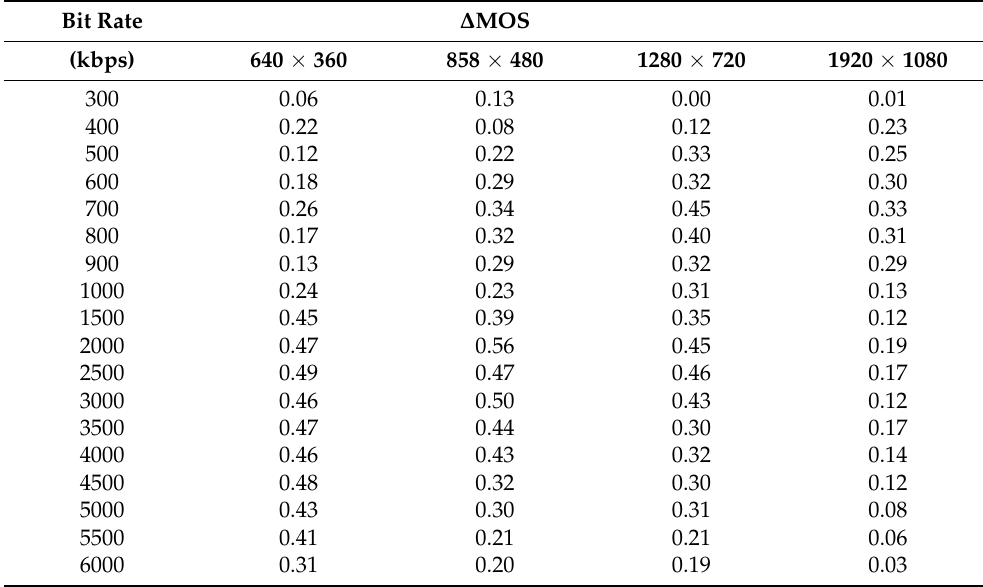
Figure 9. Results of the subjective quality assessment (MOS) for the H.265-encoded video as a function of bit rate for different spatial resolutions—measurements in the laboratory. Table 6. Value of the difference in ∆ MOS (for H.265 codec) between the results obtained under laboratory and home